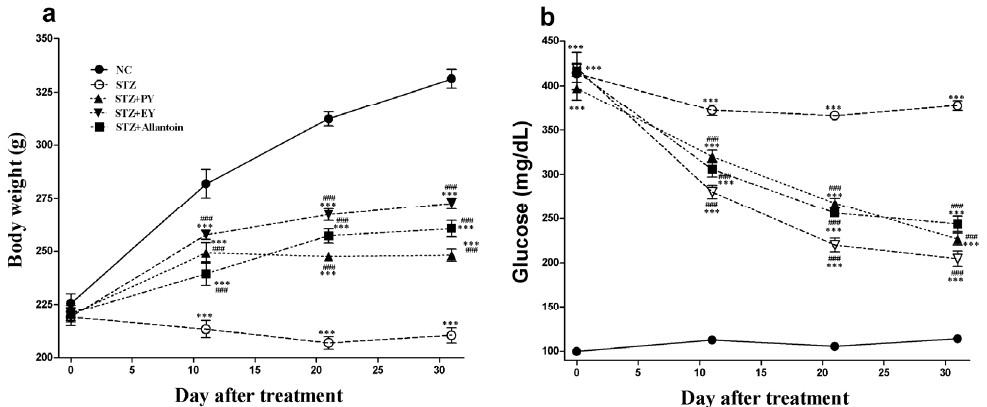
Figure 1. Effects of powdered yam (PY), extract of yam (EY), and allantoin on body weight ( a ) and fasting blood glucose ( b ) in streptozotocin (STZ)-induced diabetic rats. Data are reported as means ± SEMs ( n = 10). *: p < 0.05 and ***: p < 0.001, Bonferroni post hoc test following one-way ANOVA versus the NC group (Cont); # : p < 0.05; ## : p < 0.01; and ### : p < 0.001, Bonferroni post hoc test following two-way ANOVA versus the diabetic control group (STZ).